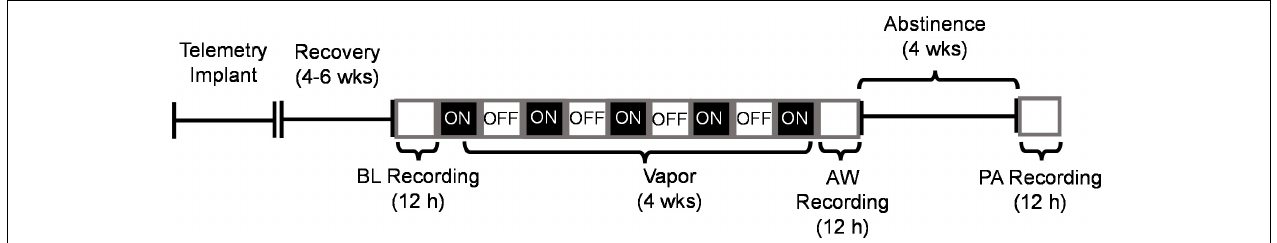
FIGURE 1 | Experiment timeline depicting recordings of sleep during baseline (BL), acute withdrawal from alcohol (AW) and following 4 weeks of protracted abstinence (PA). The open white boxes represent the light phase (ZT 0–12 h) and the black boxes represent the dark phase (ZT 12–24 h). CEIV occurred during the dark phase (as indicated by ON), and ethanol was turned OFF during the light phase. All recordings were conducted during the light phase from ZT 0–12